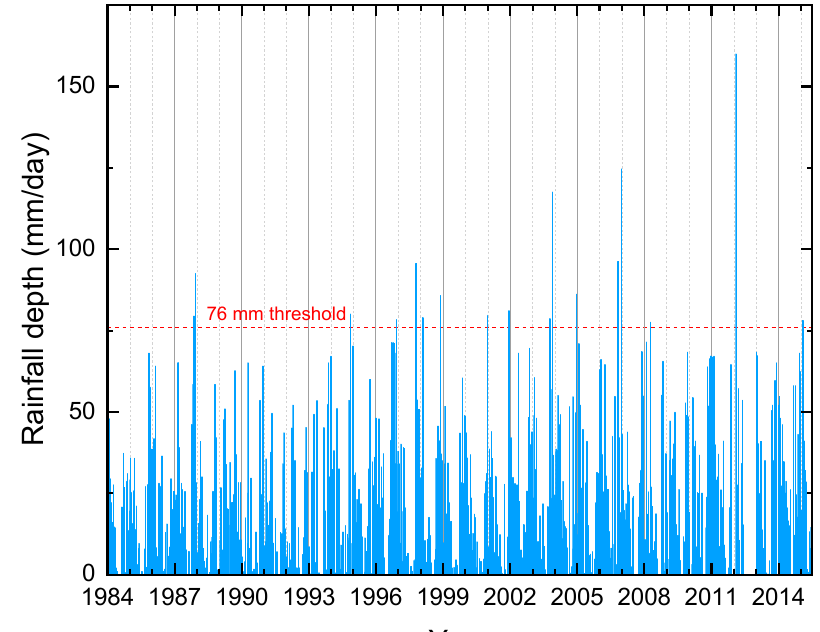
Figure 10. Daily rainfall at the Pournari I dam site between 1984 and 2015. The dashed line corresponds to a low threshold of 76 mm, above which the rainfall is regarded as a storm in [41].